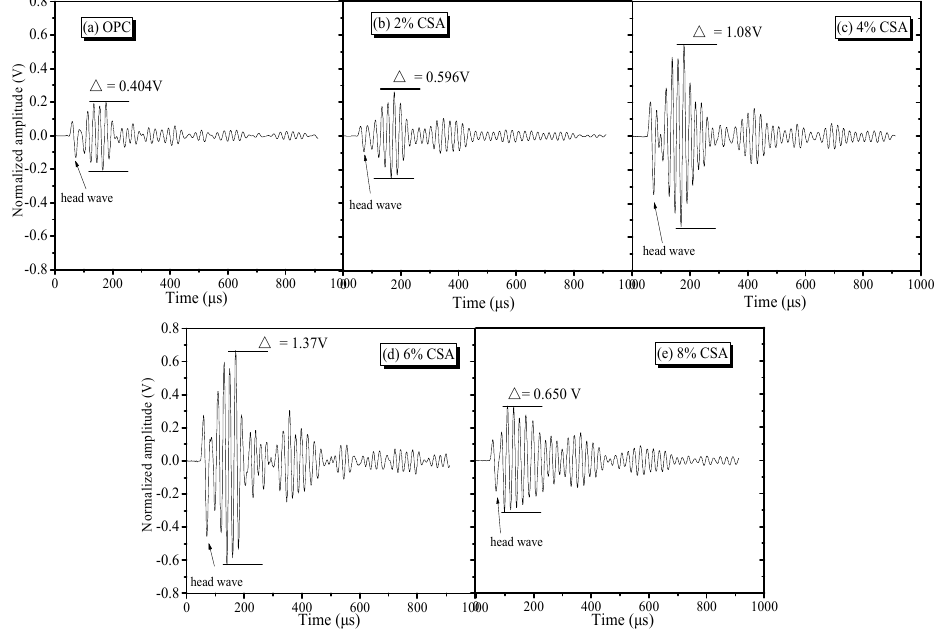
Figure 13. Time domain waveform of the ultrasonic wave of OPC and OPC/CSA cement blends, ( a ) OPC; ( b ) OPC-2%CSA cement; ( c ) OPC-4%CSA cement; ( d ) OPC-6%CSA cement; ( e ) OPC- 8%CSA cement.